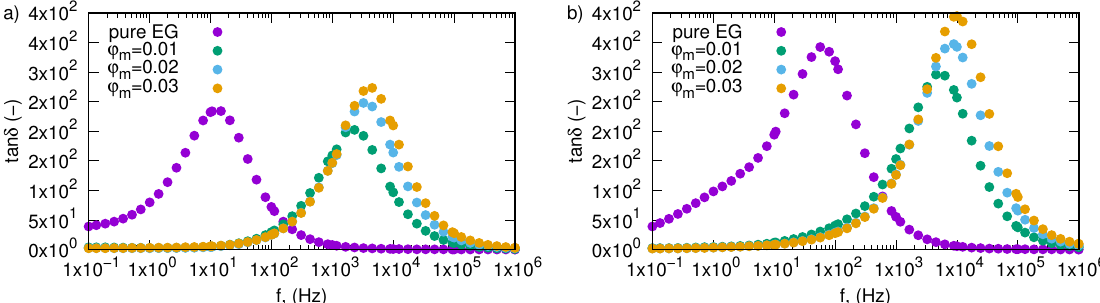
Figure 6. Dielectric loss tangent, tan δ , of silicon oxide lignin ethylene glycol nanofluids as function of frequency and temperature for ( a ) pure ethylene glycol, ( b ) 0.01 mass fraction, ( c ) 0.02 mass fraction, ( d ) 0.03 mass fraction.